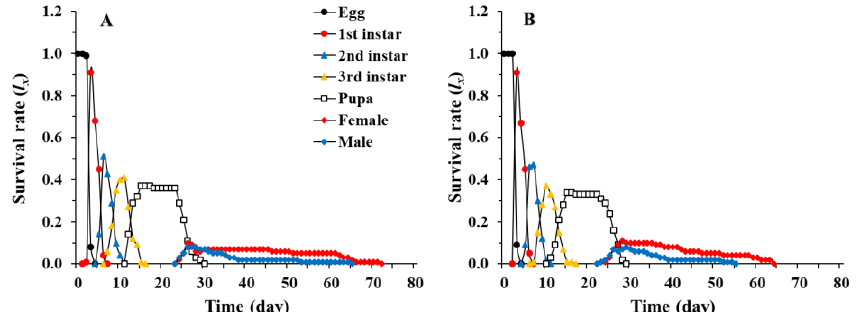
Figure 1. Age-stage specific survival rate ( 𝑆 𝑥𝑗 ) of Chrysopa pallens ever cultured on Megoura japonica ( A ) and Corcyra cephalonica eggs ( B ) under fluctuating temperature conditions in a greenhouse.